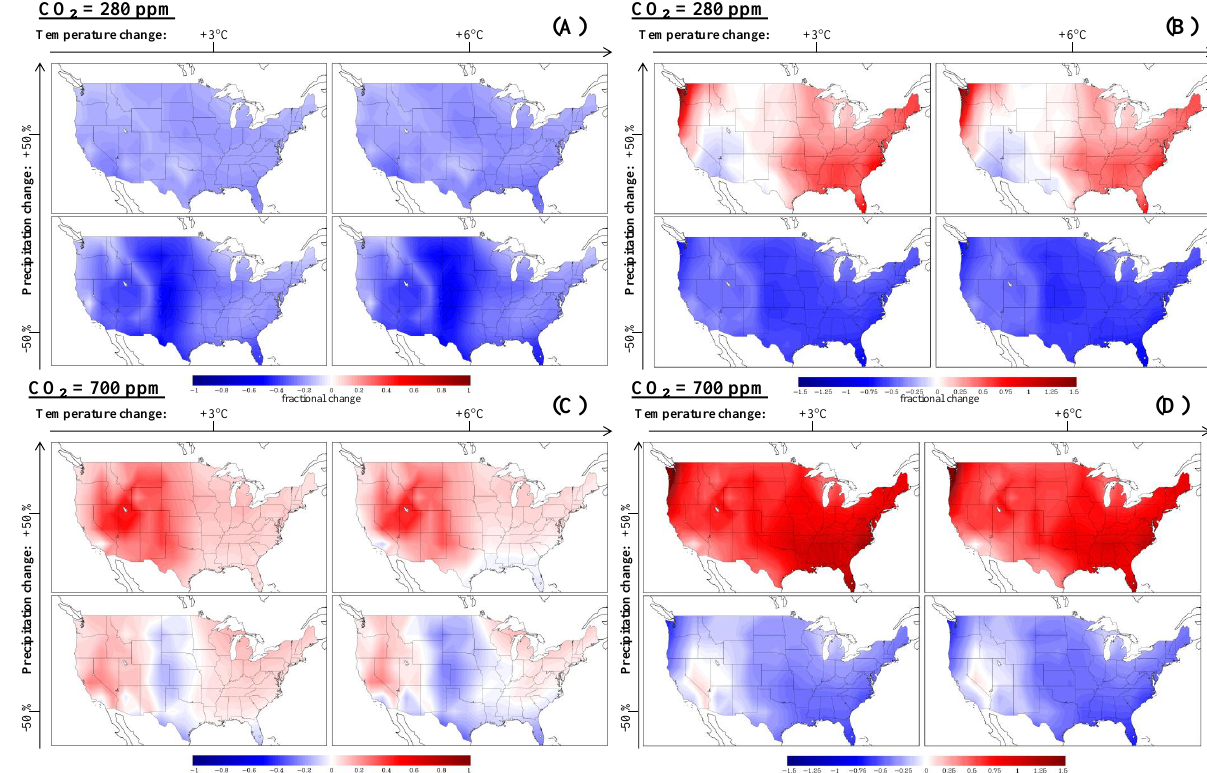
Fig. 5. Combined effects of changes in temperature, precipitation and CO 2 on soil carbon (A, C) and soil mercury (B, D) densities. A and B represent the three way interactive effects with CO 2 concentrations of pre-industrial levels (–110ppm of present-day), and C and D show effects with CO 2 elevated by 420ppm from present-day levels. Values are expressed as the fractional change of present-day